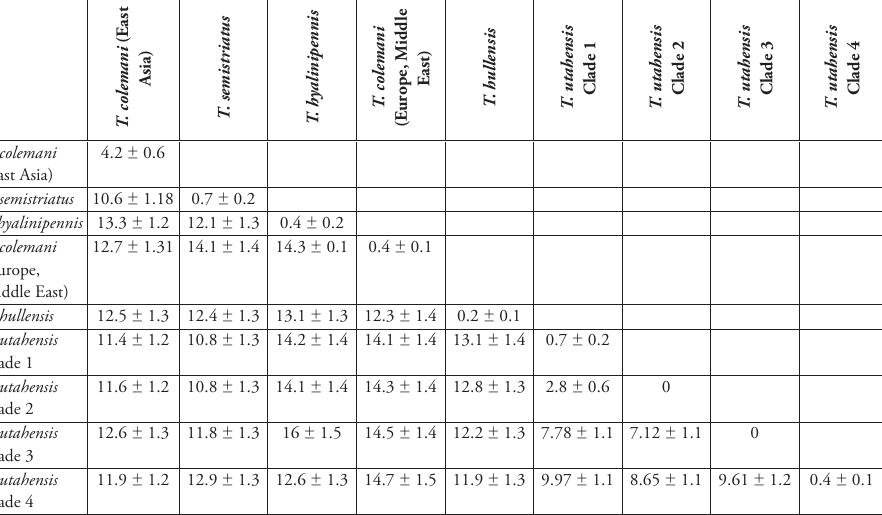
Table 2. Genetic distances (p-distances %, 1,000 bootstrap replications) for the CO1 barcode at the levels of intra-species, inter-species and clades of T. utahensis . Data are expressed as mean ±